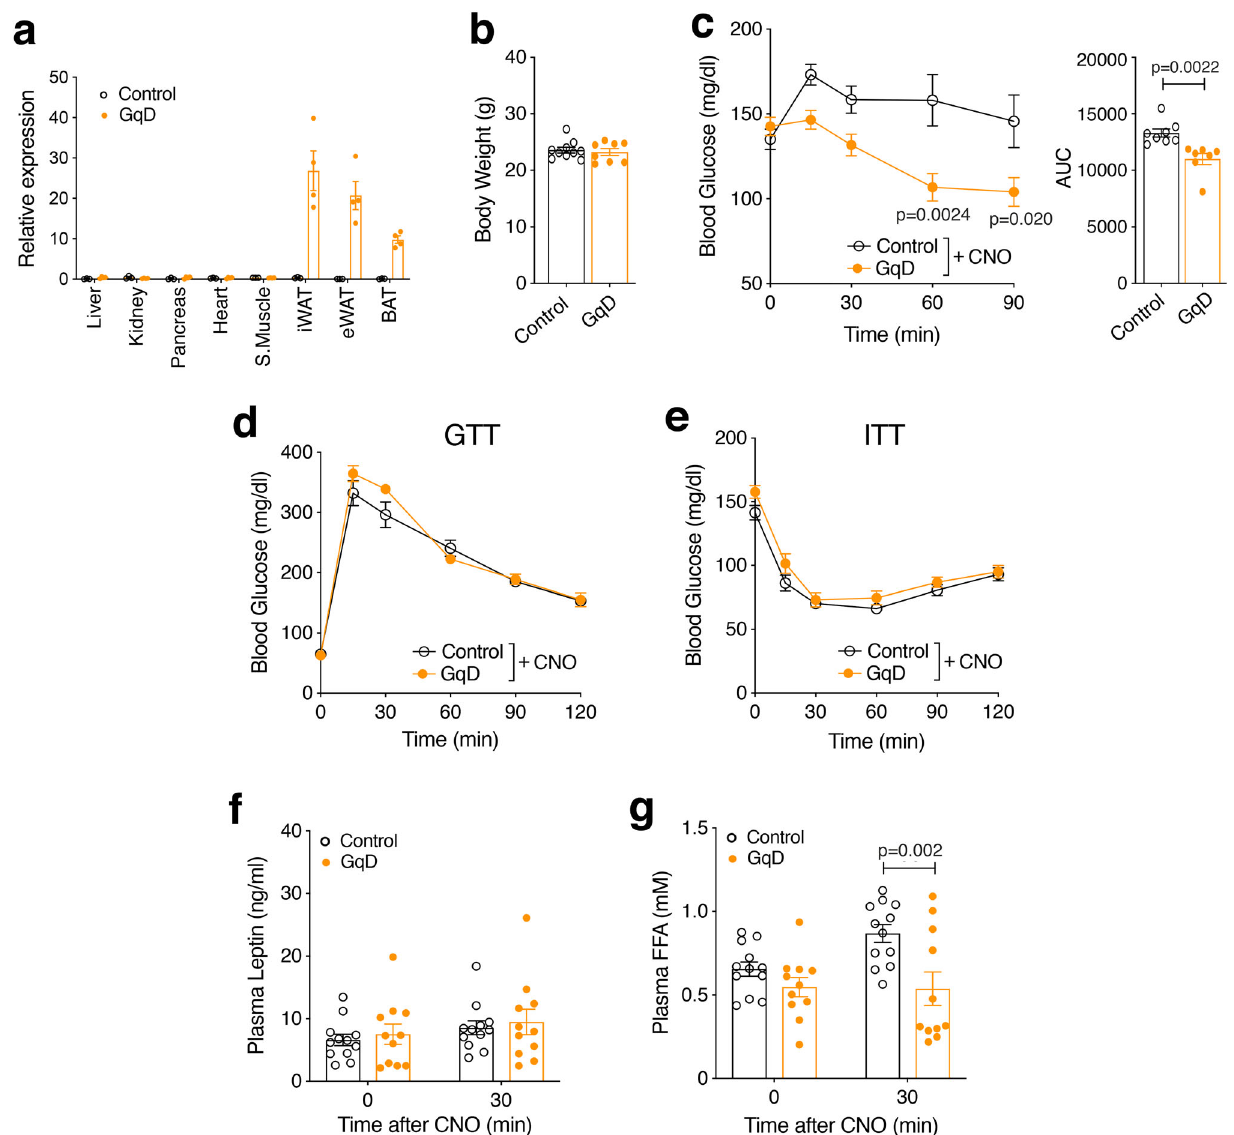
Fig. 1 Acute CNO treatment of adipo-GqD mice causes reduced blood glucose and plasma free acid levels. a Expression levels of GqD mRNA in different tissues of adipo-GqD (GqD) and control mice ( LSL-hM3Dq mice that did not harbor the adipoq-Cre transgene) ( n = 4 per group). The presence of GqD transcripts was detected via qRT-PCR. S. Muscle, skeletal muscle; iWAT, inguinal white adipose tissue; eWAT, epididymal white adipose tissue; BAT, brown adipose tissue. b Body weights of adipo-GqD and control mice (mouse age: 12 weeks; n = 8 – 10 per group). c Blood glucose levels after CNO injection (10 mg/kg i.p.) following a 4 hr fast ( n = 7 – 9 per group). d , e Effect of acute CNO treatment (10 mg/kg i.p.) on glucose tolerance ( d , GTT) and insulin tolerance ( e , ITT). GTT: 2 g glucose/kg after an overnight fast; ITT: 0.75 U insulin/kg after a 4 hr fast ( n = 8 or 9 per group). f , g , Plasma leptin ( f ), and plasma free fatty acid (FFA) ( g ) levels of control and adipo-GqD mice 30 min after injection of CNO (10 mg/kg i.p.) following a 4 hr fast ( n = 11 or 12 per group). Metabolic tests ( c – g ) were carried out with male mice that were 10-16 weeks old. Data are presented as means ± s.e.m. b , c (AUC), f , g : two tailed Student ’ s t-t est; c – e : two-way ANOVA followed by Bonferroni ’ s post hoc test). Source data are provided as a Source data fi